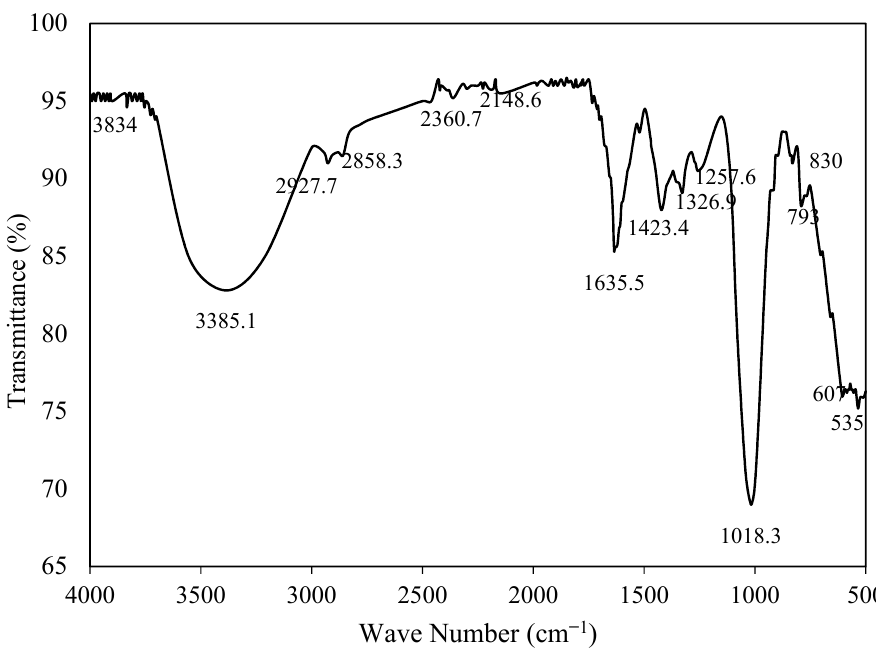
Figure 3. Infrared spectra of Aloe vera . The bands at 1257.6 cm − 1 and 1018.3 cm − 1 indicate the presence of COO stretching Carboxylic acid salt [46] and CO of ester [31],